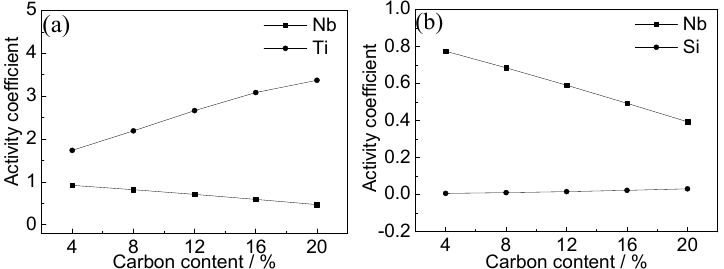
Figure 12. Variation of the activity coefficients of the elements Nb, Ti, and Si with changes in the carbon concentration in the systems ( a ) Nb–Ti–C and ( b ) Nb–Si–C.